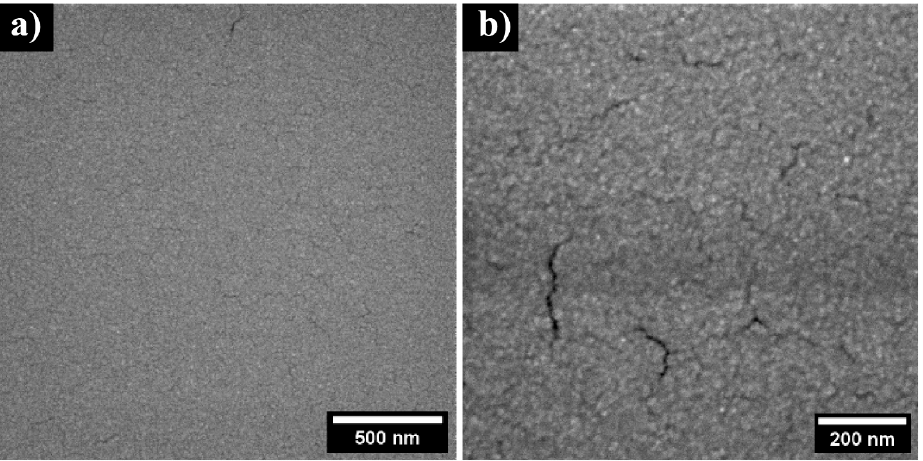
Figure 5. SEM images of the Fe 2 O 3 :ZnO film with 500 nm ( a ) and 200 nm ( b ) scale bars. The Fe 2 O 3 :ZnO target material and the sputtered film were also well studied by the EDX elementary analysis. The availability of Fe, Zn, and O peaks both in the target material and in the film obviously present the weight and atomic percentage of these elements (Figure 6). The real concentrations of Zn in the target material and in the film are 21.2 wt.% and 19.4 wt.%, respectively, faintly deviating from the initial calculated value (20 wt.%). Such deviations are assumed to be caused by the errors of the measuring instruments and the peculiarities of the technological processes.